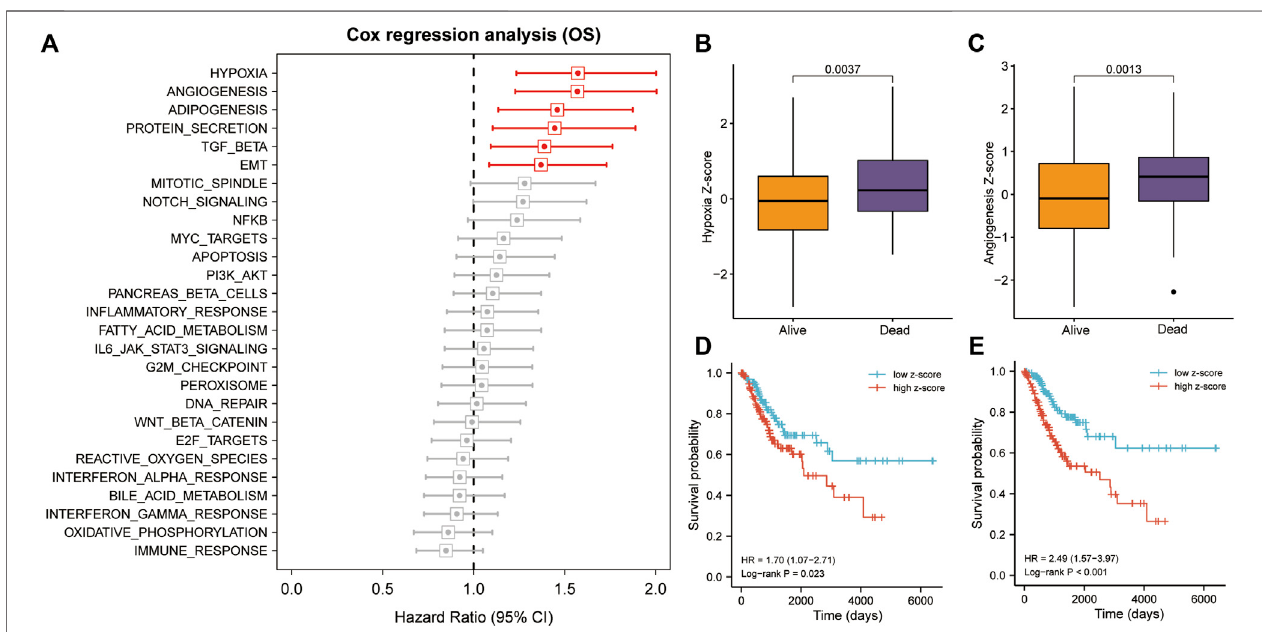
FIGURE2| HypoxiaandangiogenesiswerethekeycancerhallmarksaffectingOSinpatientswithCC. (A) Hypoxiaandangiogenesishadastrongin fl uenceonOS, according to the univariate Cox-PH regression. (B,C) Patients with CC who died during follow-up had signi fi cantly higher z-scores for hypoxia and angiogenesis. (D,E) Patients with high hypoxia and angiogenesis z-scores had poorer OS, according to KM analysis. TGF, transforming growth factor; NFKB, nuclear factor kappa B; PI3k/ Akt, phosphatidylinositol-3- kinase/serine-threonine kinase; EMT, epithelial-mesenchymal transition; KM, Kaplan – Meier.